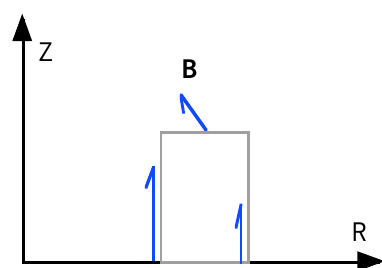
R (cid:66) (cid:100) (cid:108) around the dotted line FIG. 15. (Color) The integral of must be zero if no current is